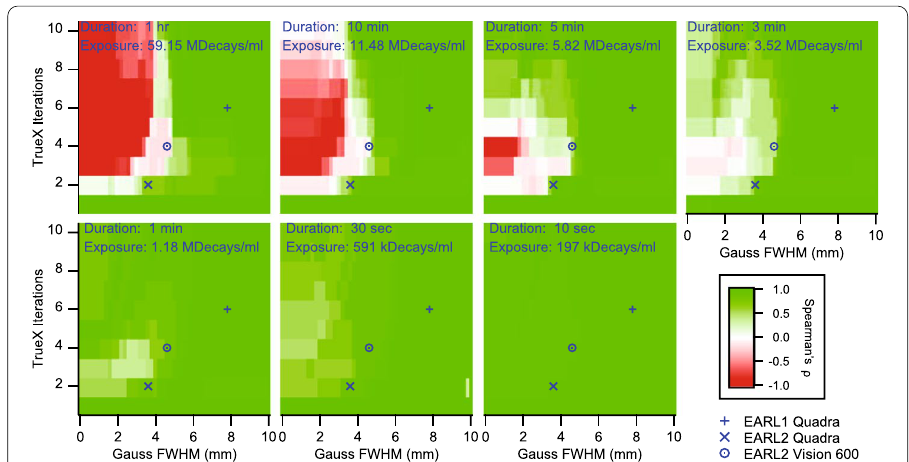
Fig. 6 Monotonicity of RC max recovery curves: Shown is the Spearman’s ρ as a function of number of TrueX iterations and post‑reconstruction Gauss FWHM for different exposures. The markers designate the herein proposed reconstruction parameters for EARL1, EARL2, and EARL2 Vision compliant data. All 3 s frames displayed monotonically rising RC